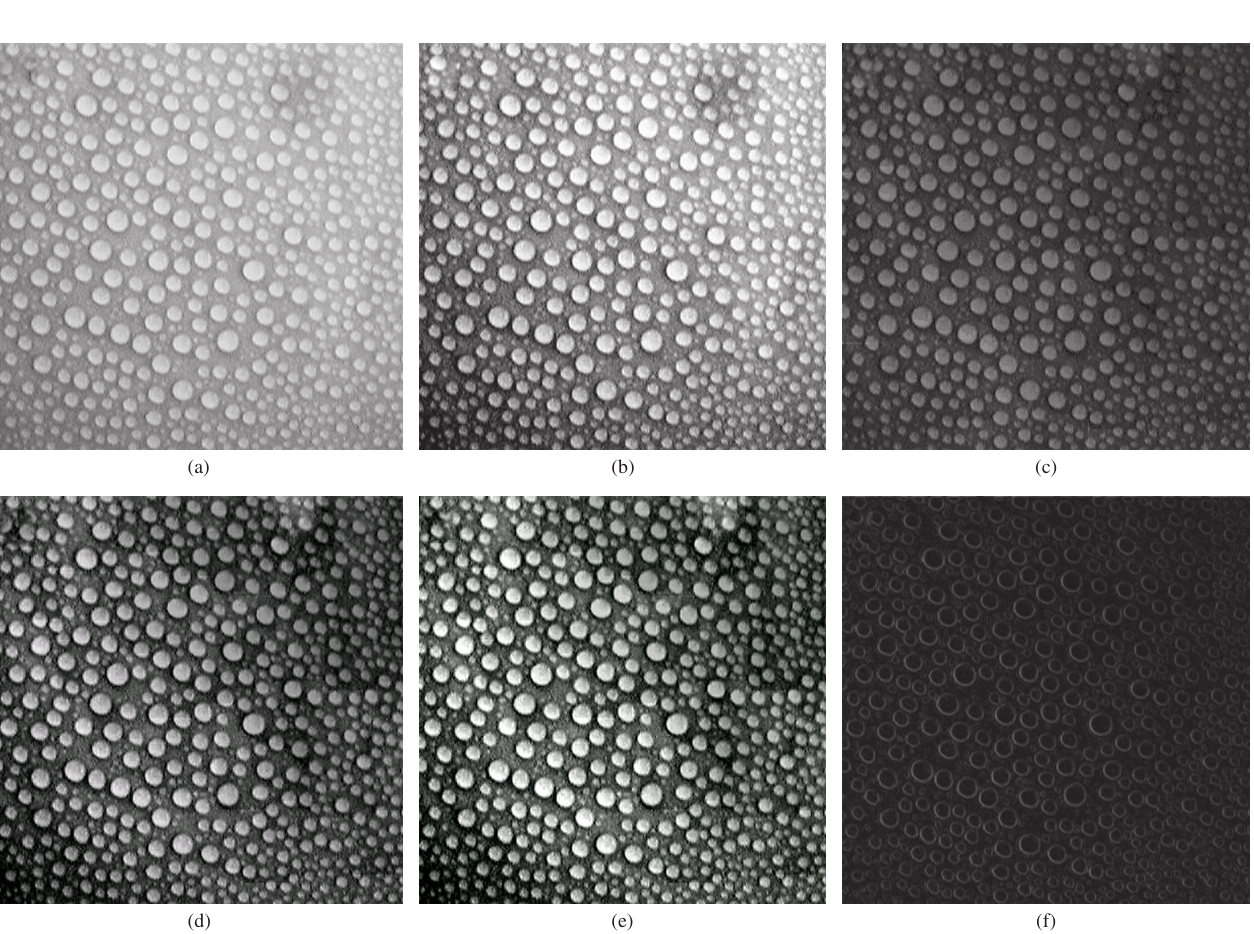
Figure 5. Images produced by various models of illumination adjustments: a) OR, b) EQU, c) WTH, d) EQU+WTH, e) EQU+WTH+EQU and f) SOB im- ages.